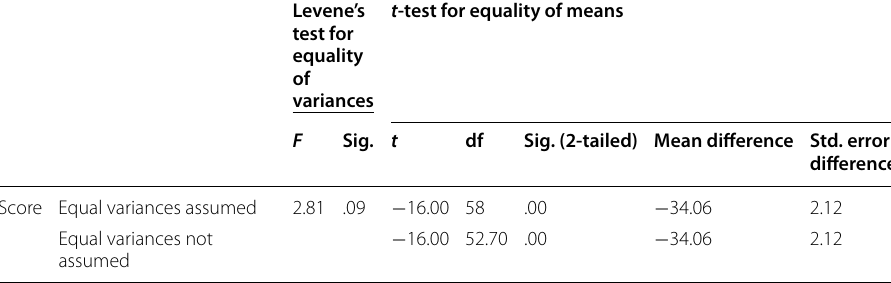
Table 29 Inferential statistics (autonomy post‑test of both groups)